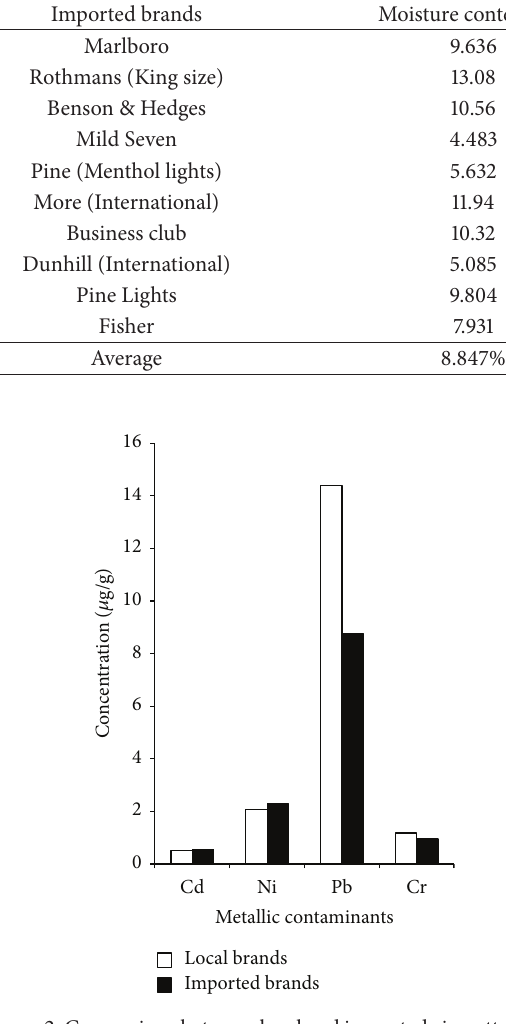
Figure 2: Comparison between local and imported cigarette brands in